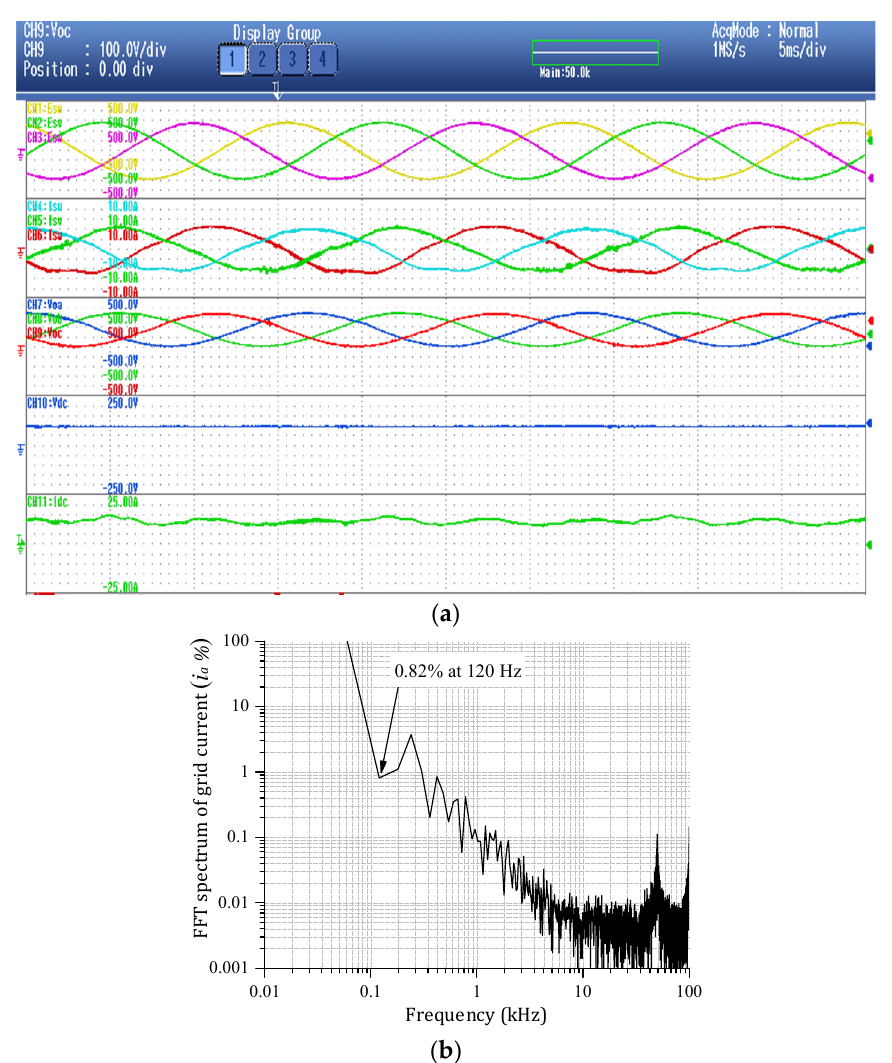
Figure 16. Experimental system results with SOHC compensation. ( a ) Converter results with SOHC compensation. ( b ) Grid current FFT harmonic spectrum with SOHC compensation. Table 7. Experimental parameters of the MFBDI.